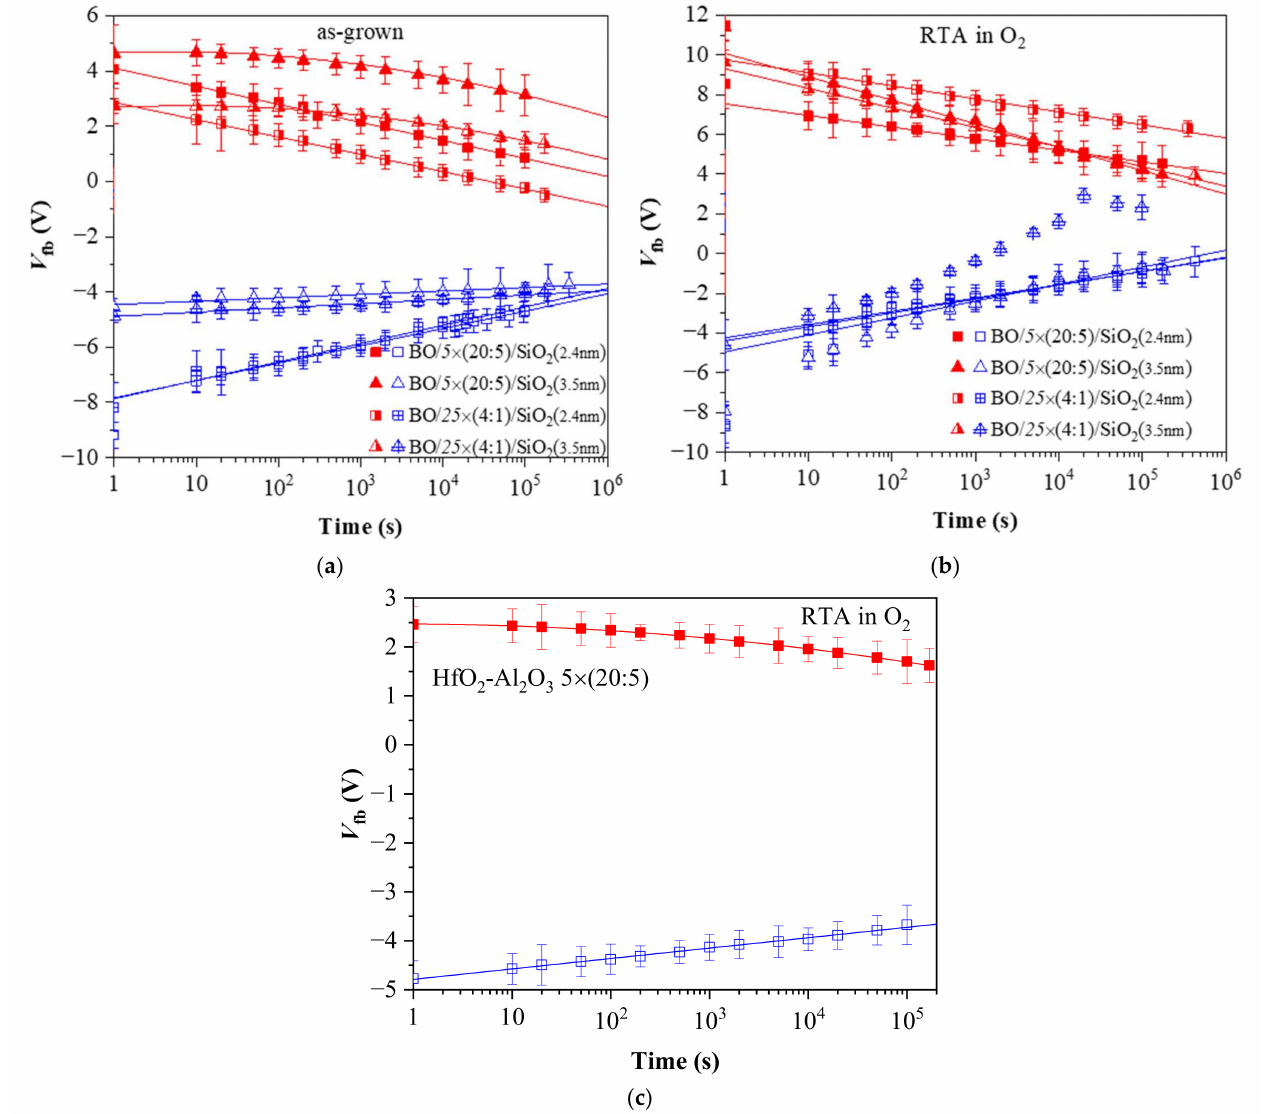
Figure 5. Charge retention characteristics in capacitors with various HfO 2 -Al 2 O 3 stacks: ( a ) before and ( b ) after RTA in O 2 ; ( c ) HfO 2 -Al 2 O 3 5 × (20:5) stack without BO and TO after RTA. The filled red symbols correspond to a negative charge (respectively, positive values of V fb ) and the open blue ones correspond to a positive charge (negative values of V fb